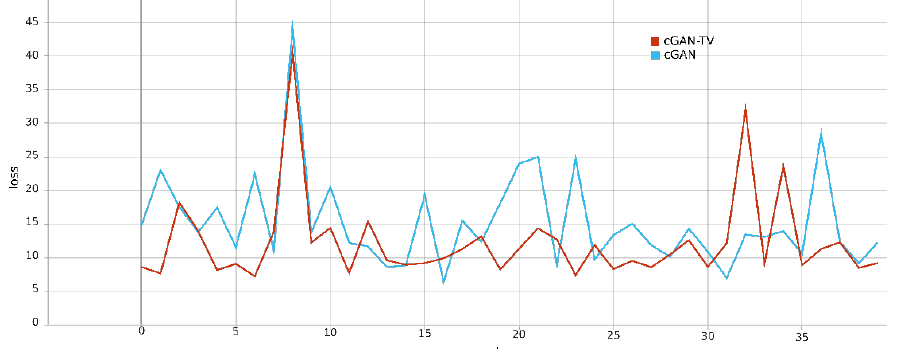
Figure 11. Loss values of cGAN and cGAN-TV for every 1000 epochs.